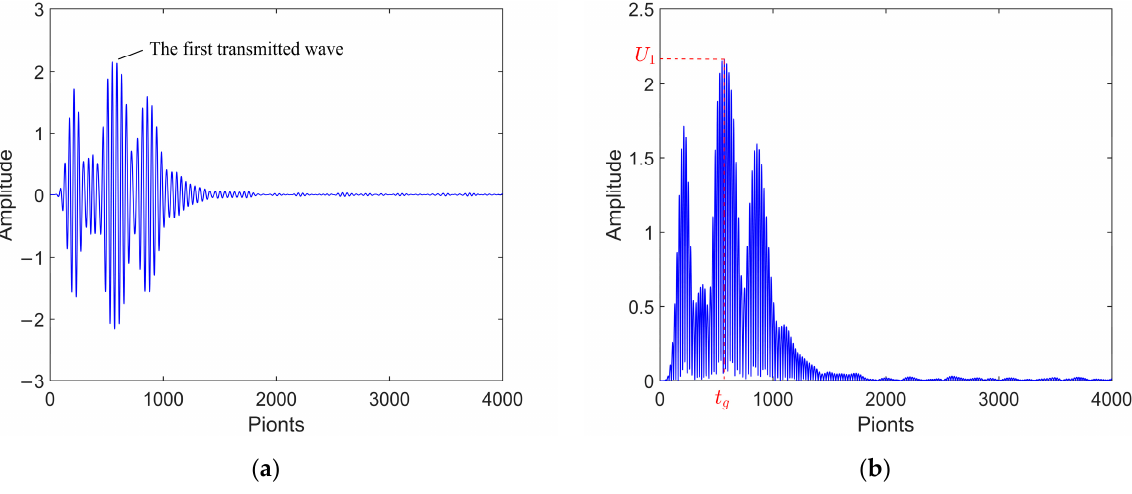
Figure 3. CRC similarity model transmission wave data. ( a ) The original data; ( b ) the absolute value data.